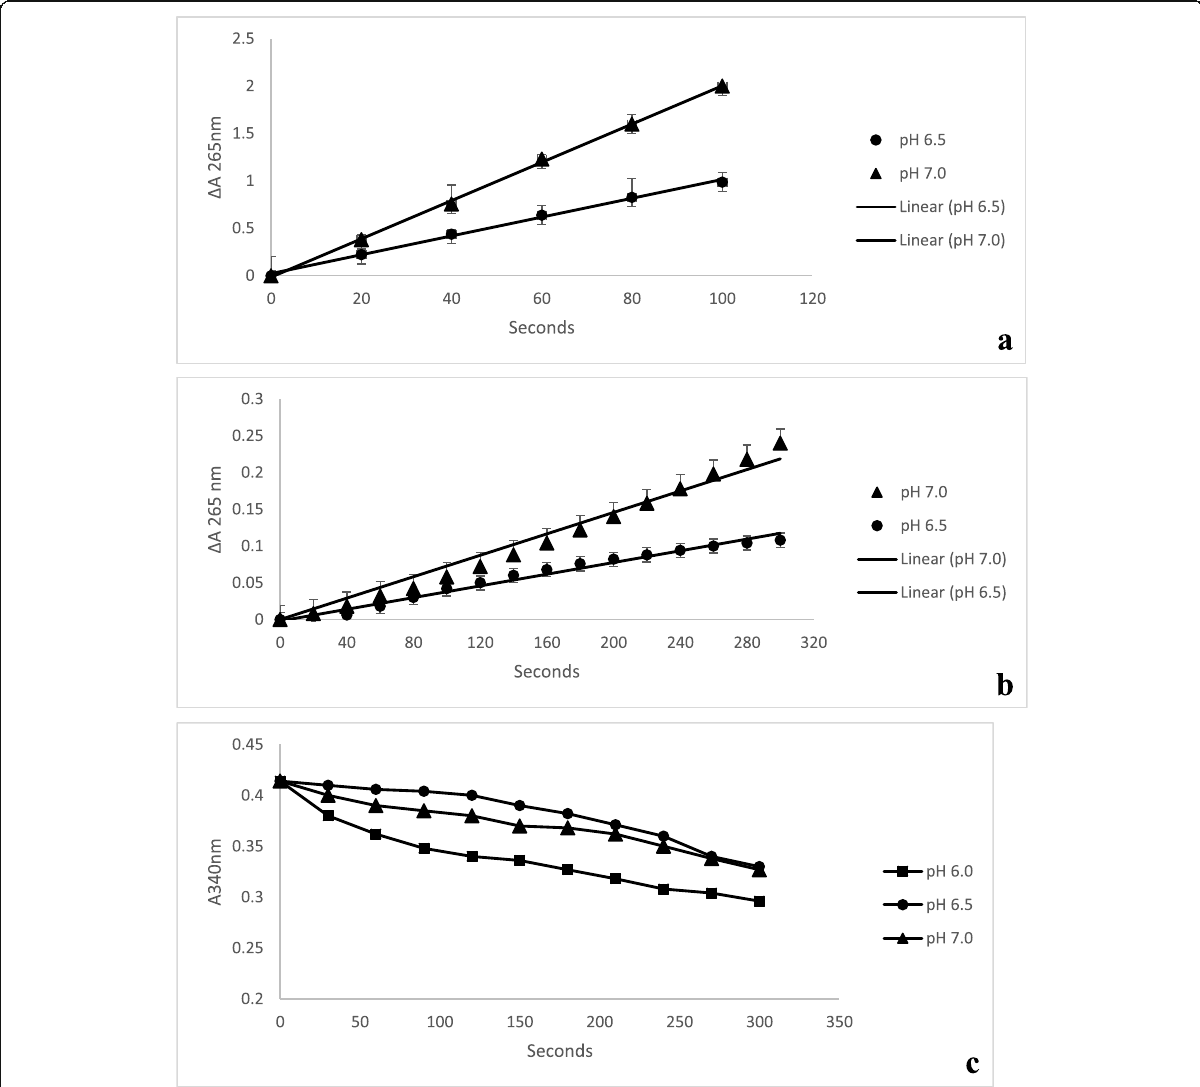
Fig. 4 Dehydroascorbate reductase activity of storage protein of the aerial tuber of D. bulbifera at pHs 6.5 and 7 with ( a ) or without ( b ) 4 mM glutathione and ( c ) monodehydroascorbate reductase activity of the storage protein of the aerial tuber of D. bulbifera at pHs 6, 6.5 and